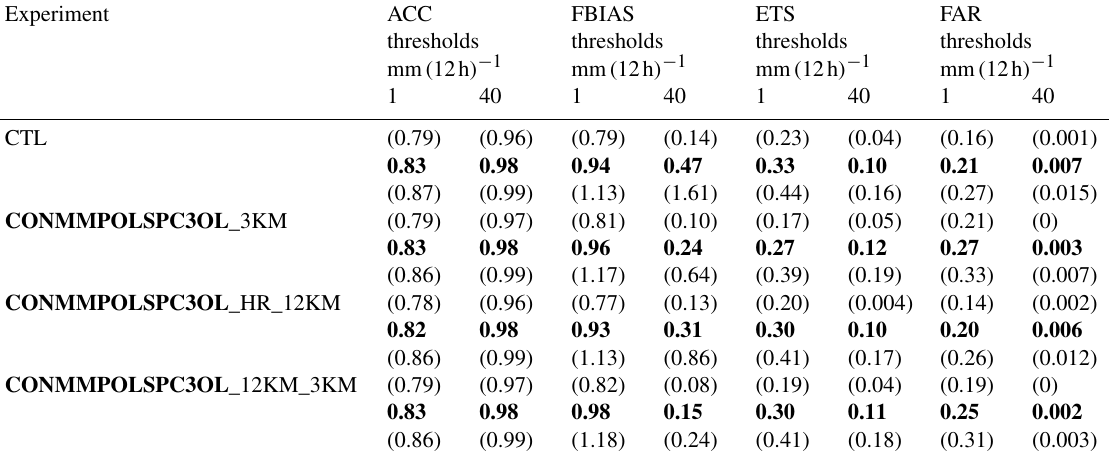
Table 5. Bootstrap 95% confidence intervals for verification statistics forecast accuracy (ACC), frequency bias (FBIAS), equitable threat score (ETS), false alarm ratio (FAR), and referring to experiments in line 5 of Fig. 7. They are considered as a function of thresholds (1 and 40mm ( 12h ) − 1 ). The experiments are CTL, CONMMPOLSPC3OL_3KM,